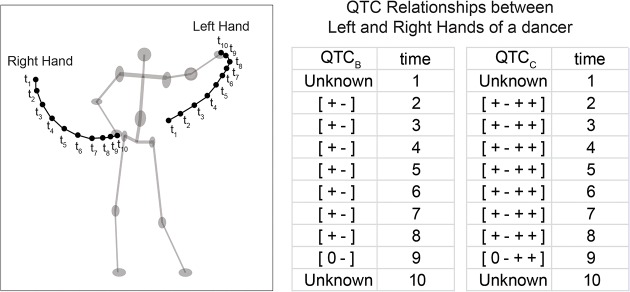
QTCB and QTCC relations of the movement of two hands of a dancer.